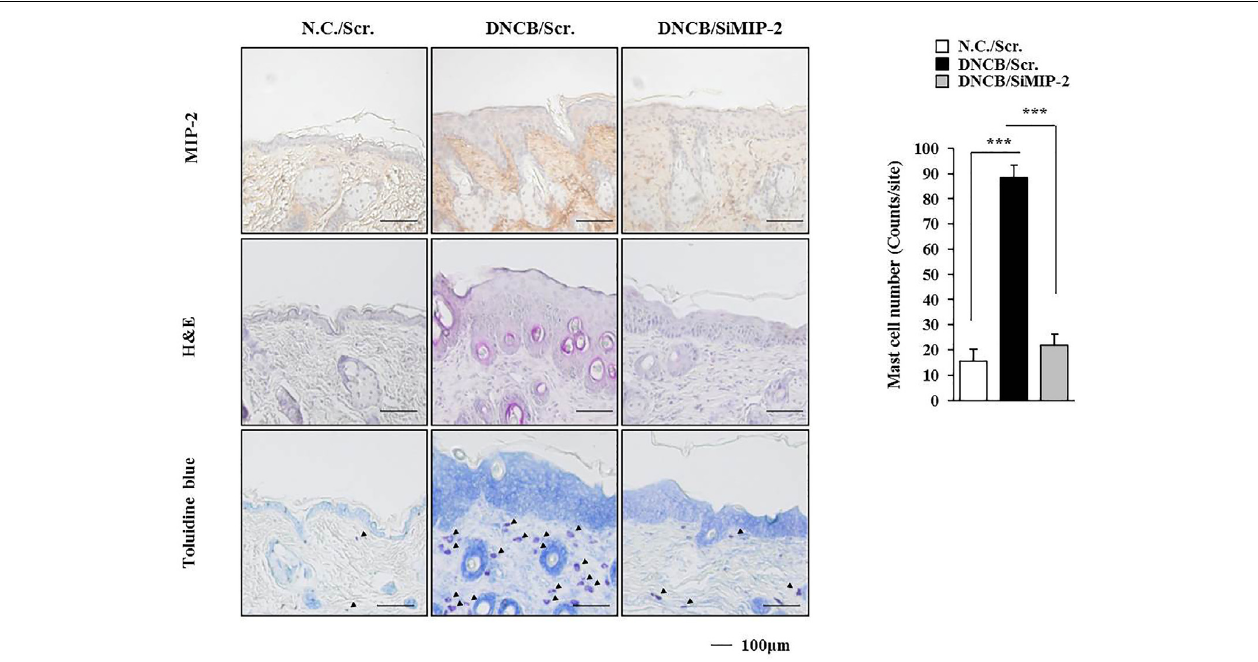
FIGURE 5 | Induction of the features of AD occurs in an MIP-2-dependent manner. Skin tissues of BALB/c mice of each experimental group were isolated at the time of sacrifice and were subjected to immunohistochemical staining by employing anti-MIP-2 antibody (2 µ g/ml) and H&E staining. Toluidine blue staining was also performed to determine the number of degranulated mast cells. Closed triangle represents degranulated mast cells. ∗∗∗ p <